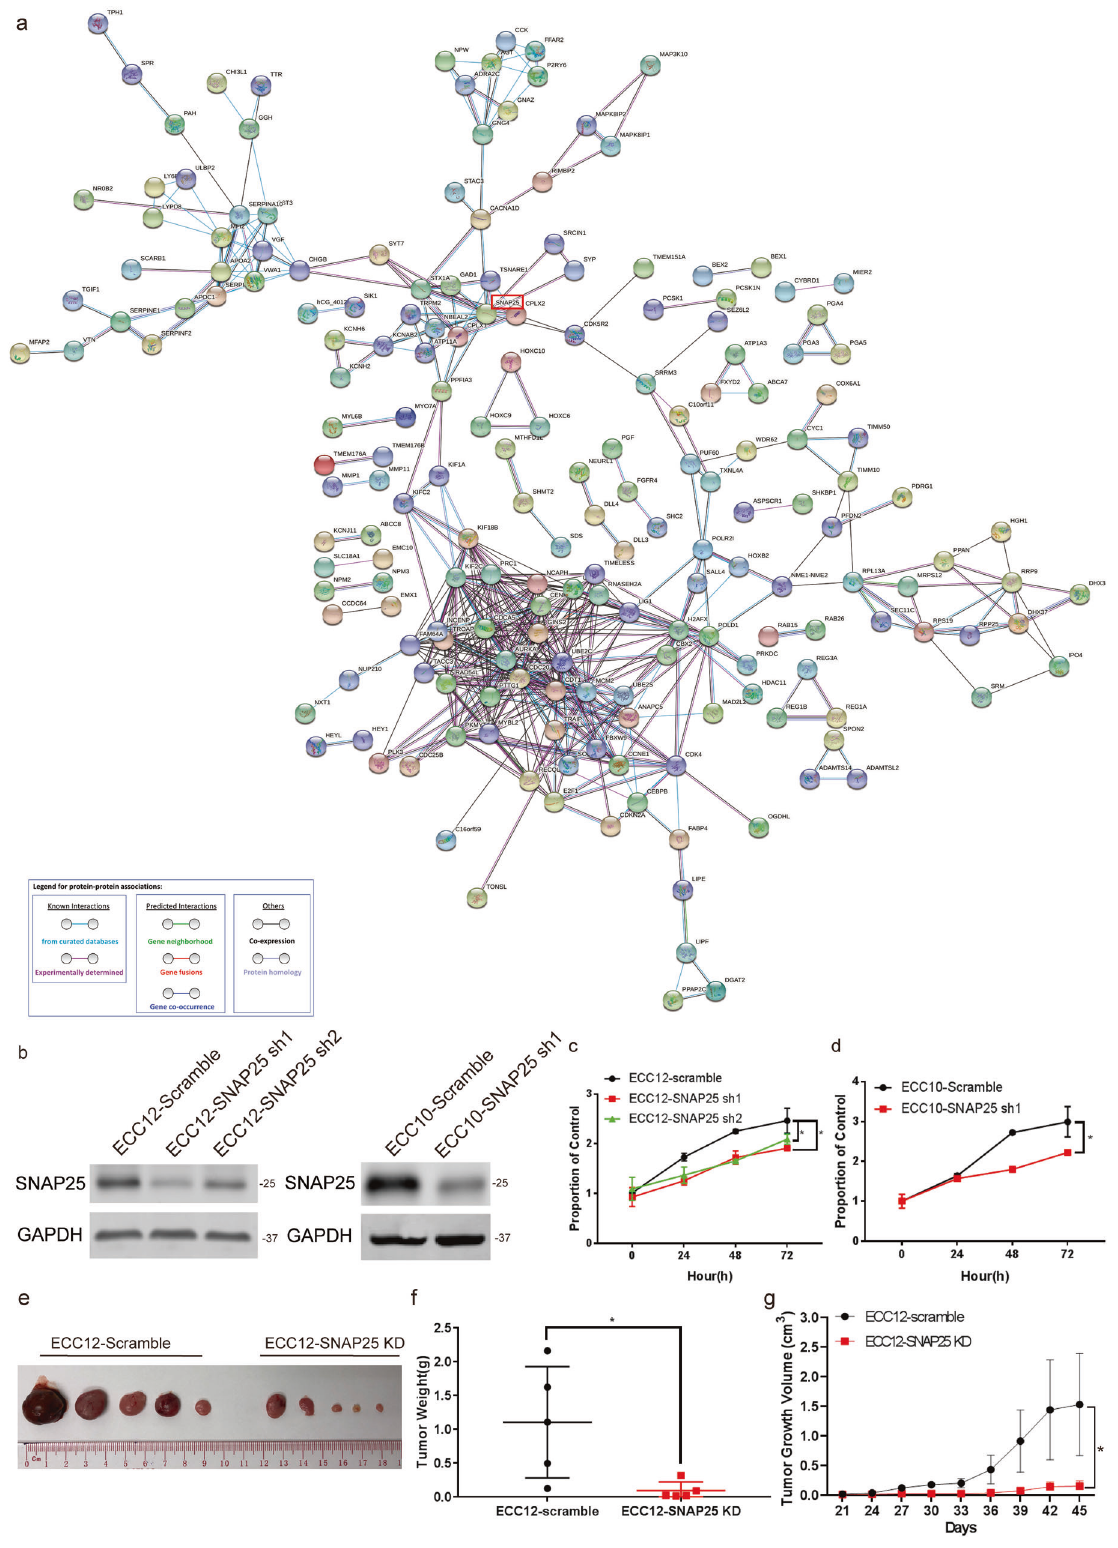
Fig. 3 PPI network analysis of GNEC DEGs and the effect of SNAP25 on GNEC cell proliferation. a PPI analysis of GNEC DEGs. b SNAP25 knockdown effect in GNEC cell lines. c , d The changes in proliferation in SNAP25 knockdown GNEC cell lines. e – g The growth rate of SNAP25 knockdown GNEC cells in a xenograft model. Plots indicate the average ± s.d. Signi fi cance test is indicated *( p < 0.05).